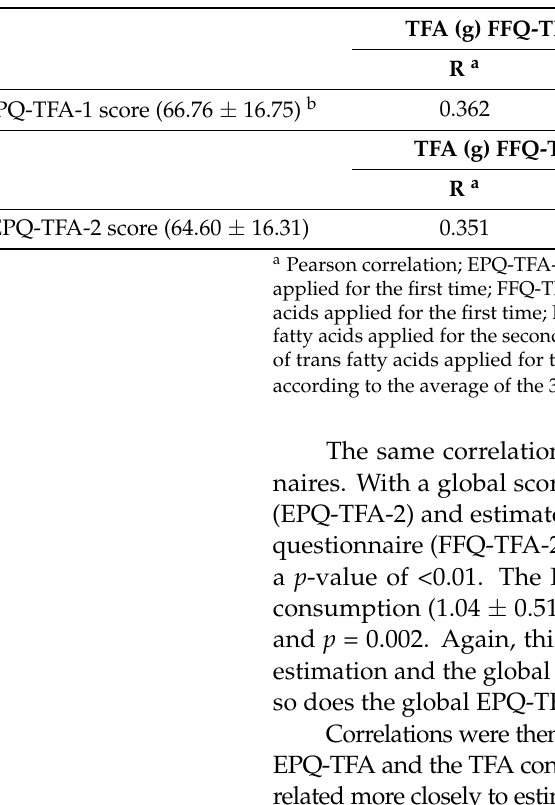
Table 5. Relationship between the consumption of TFA estimated by the FFQ-TFA-2 and the global score of the